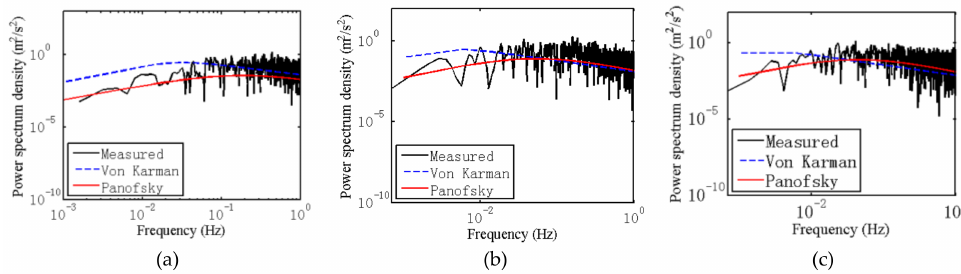
Figure 32. Power spectra of the vertical wind component at ( a ) 10 m, ( b ) 80 m, and ( c ) 100